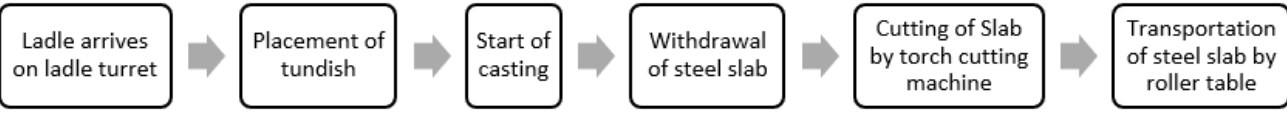
Figure 4. Process flow of continuous casting shop.